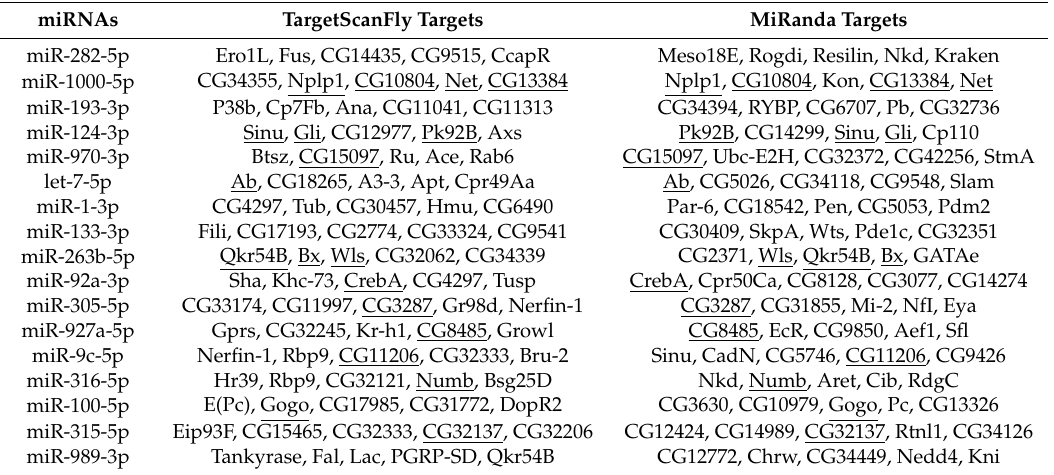
Table 4. Target prediction of select L. decemlineata miRNAs with TargetScanFly and miRanda.